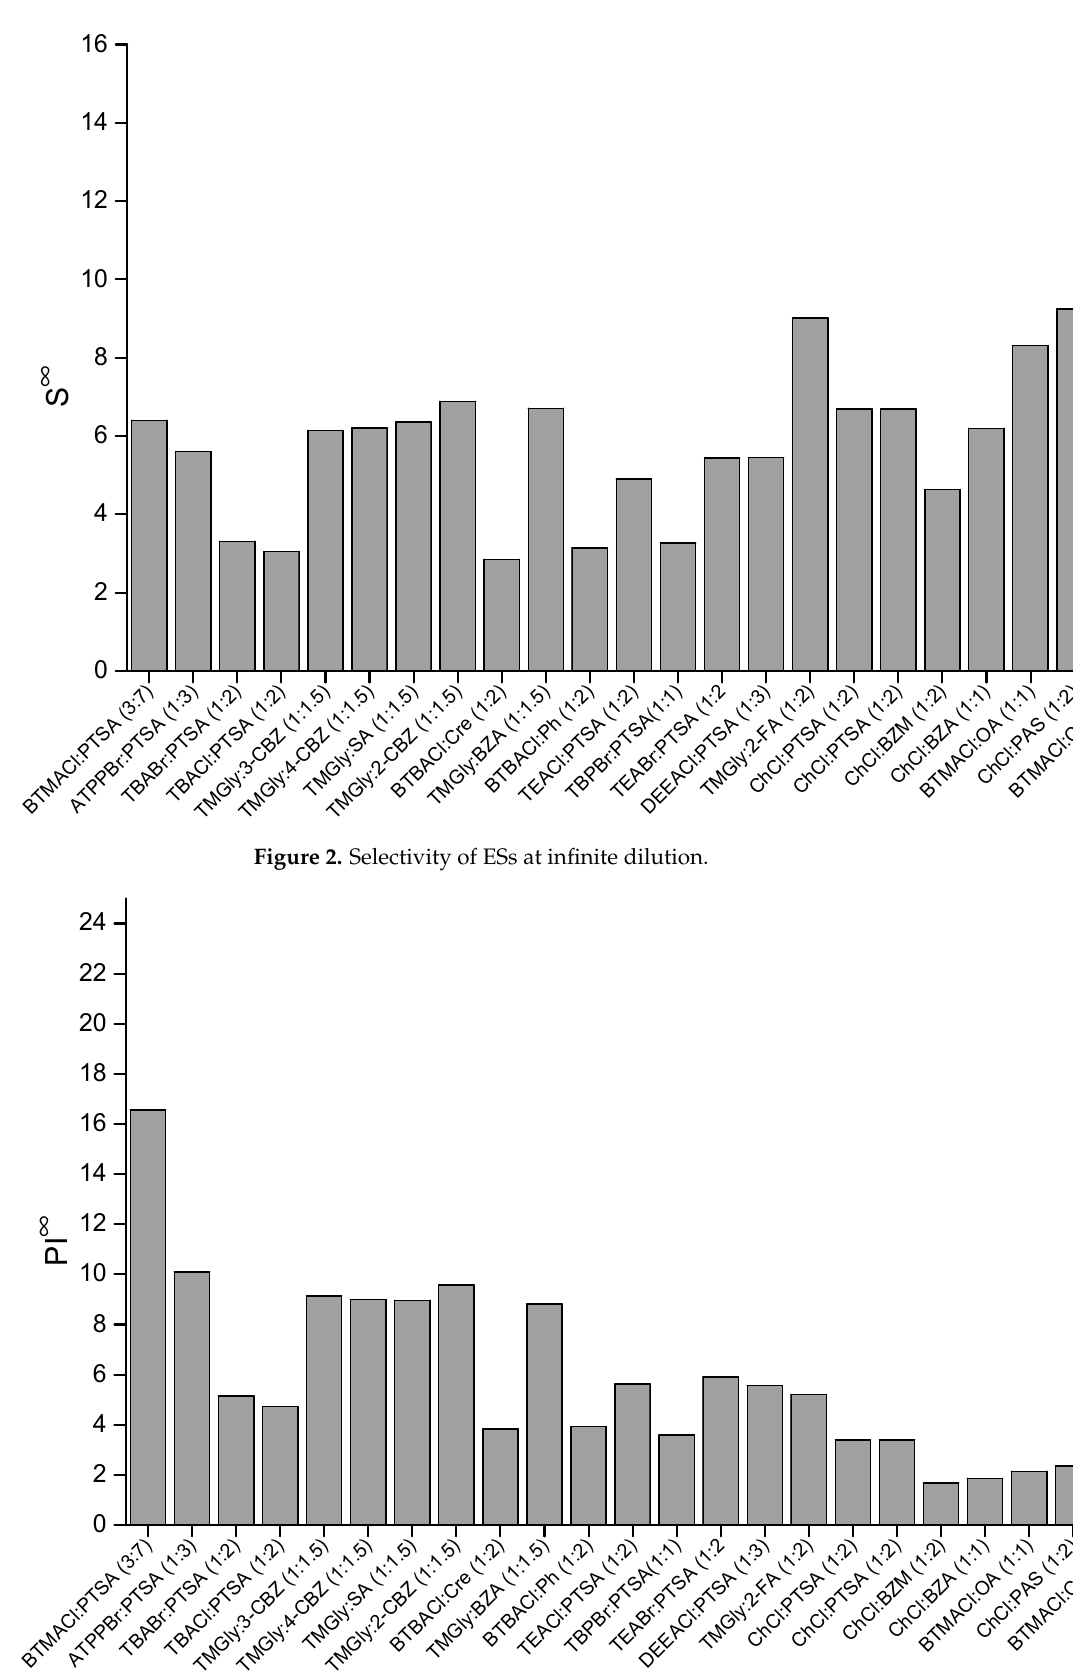
Figure 3. Performance index of ESs at infinite dilution.